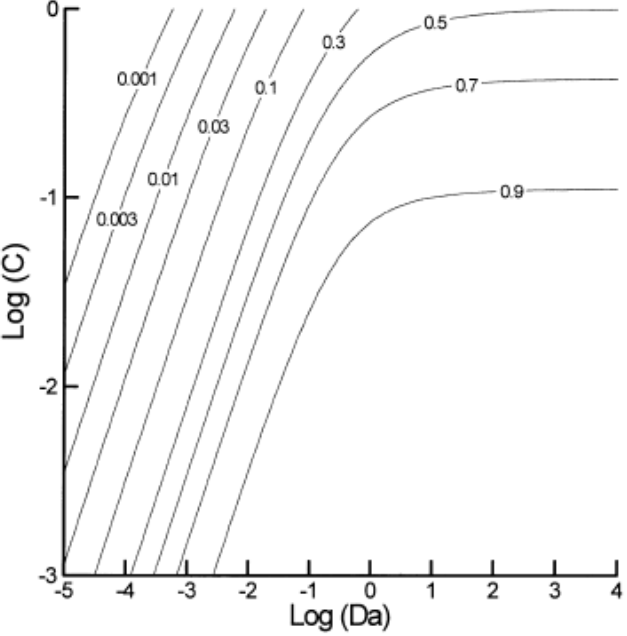
Figure 10. Error map based on porosity-scaled fluid-to-solid thermal conductivity ratio ( C ) and Darcy number (Da) using one-equation model, presented by Kim et al.